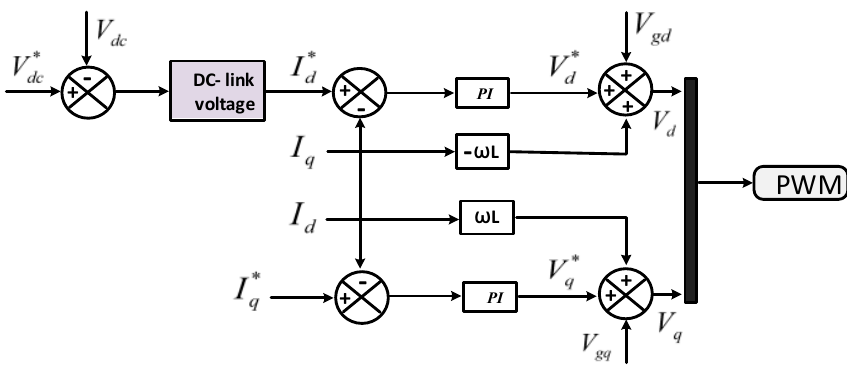
Figure 4. The control scheme for the grid-connected inverter.